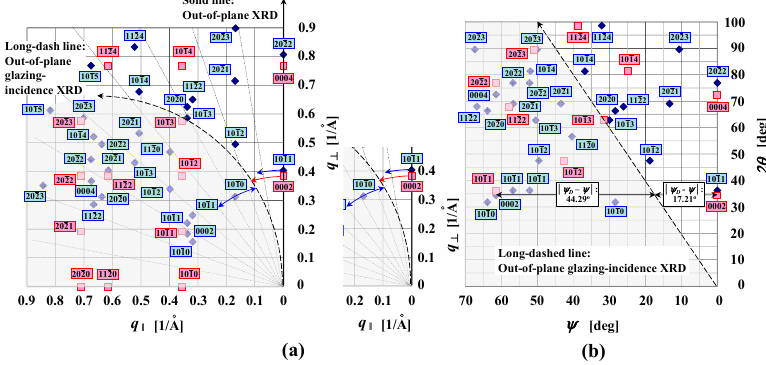
Solid line: Out-of-plane XRD